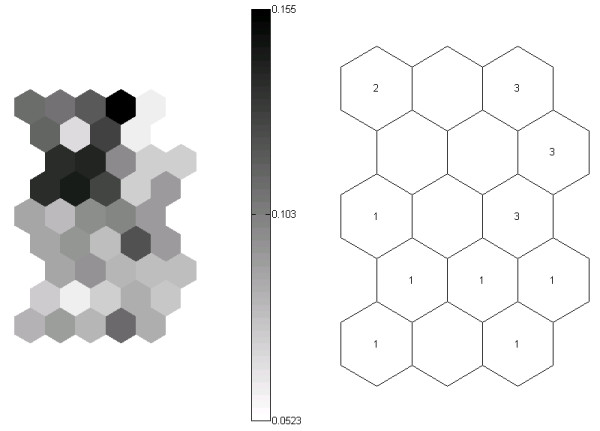
SOM-based analyses on the SRBCT data. U-matrix and label map (panel on the right side). U-matrix depicts the distances between neighbouring map units using a grey scale. In the label map a node represents a class based on a majority voting strategy for the samples associated with this node. EWS, RMS and BL samples are represented by symbols '1', '2', '3' respectively. Additional file 1 shows its frequency map.